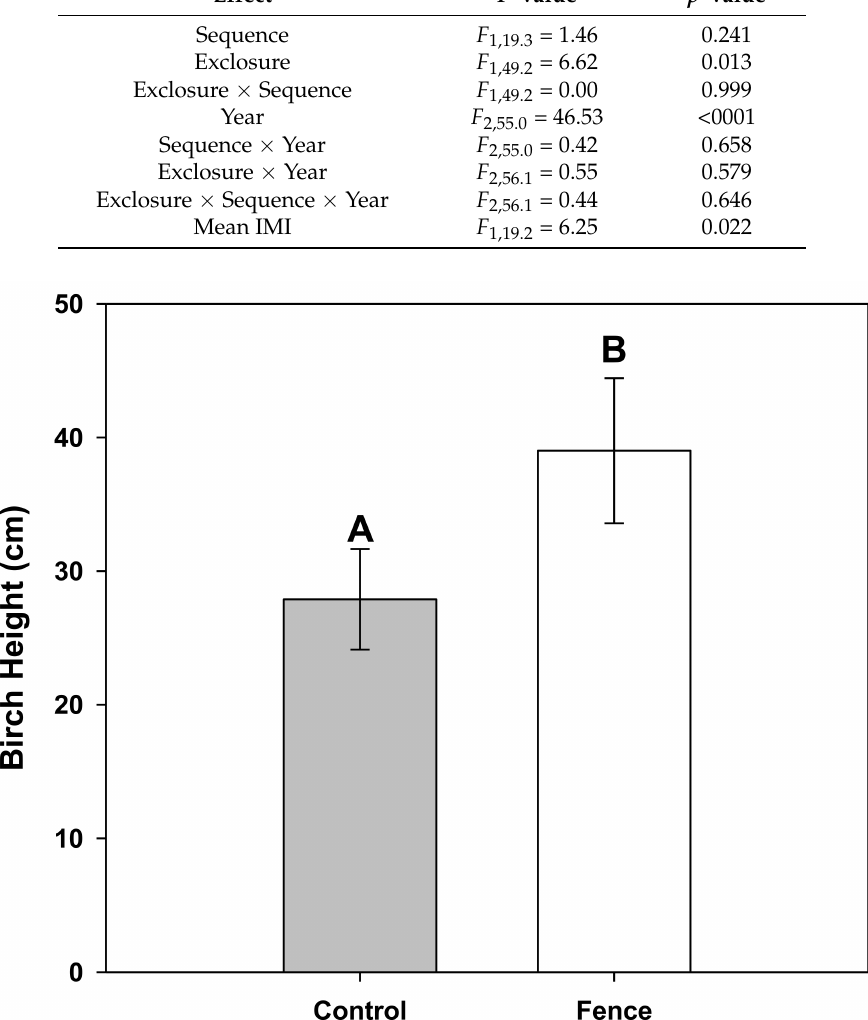
Figure 4. Effect of white-tailed deer browsing on birch height, averaged across all census periods. Letters denote a significant difference exists between browsing